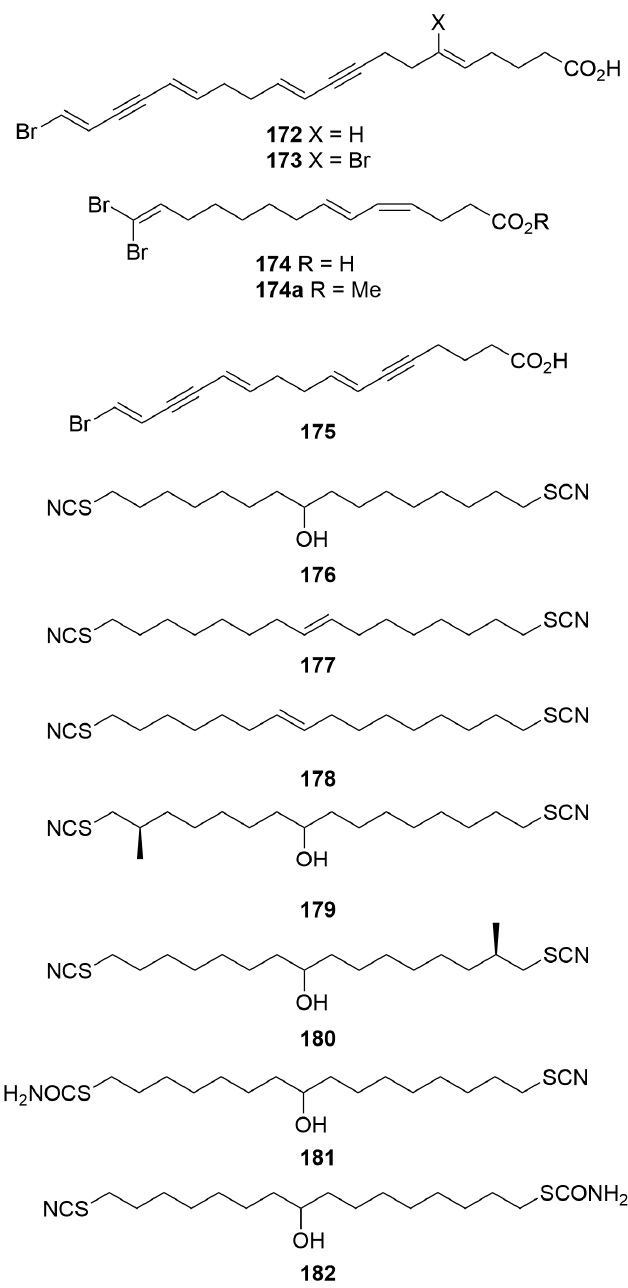
Figure 11. Compounds 172 to 182